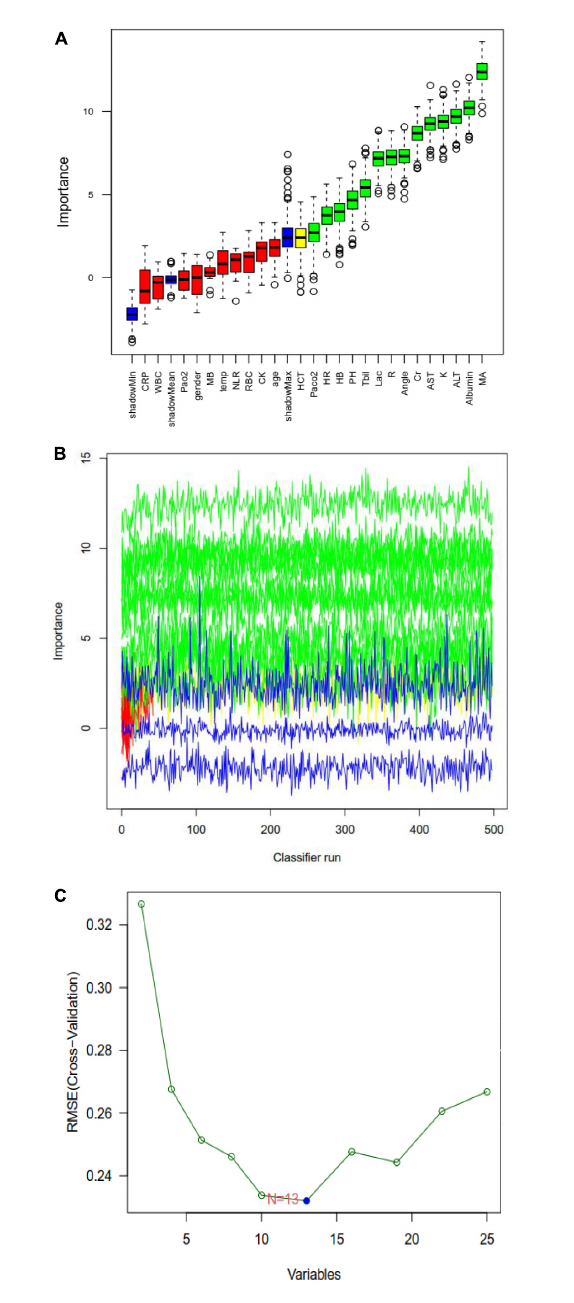
FIGURE3 Random forest analysis to identify clinical features that may predict disseminated intravascular coagulation (DIC) in heatstroke patients. (A) Boxplot for all features in random forest analysis. Green indicates important variables; red, blue, or yellow, rejected variables. (B) Rejection or acceptance of factors during random forest classification runs. (C) Support vector machine-recursive feature elimination (SVM-RFE) to identify clinical predictors of